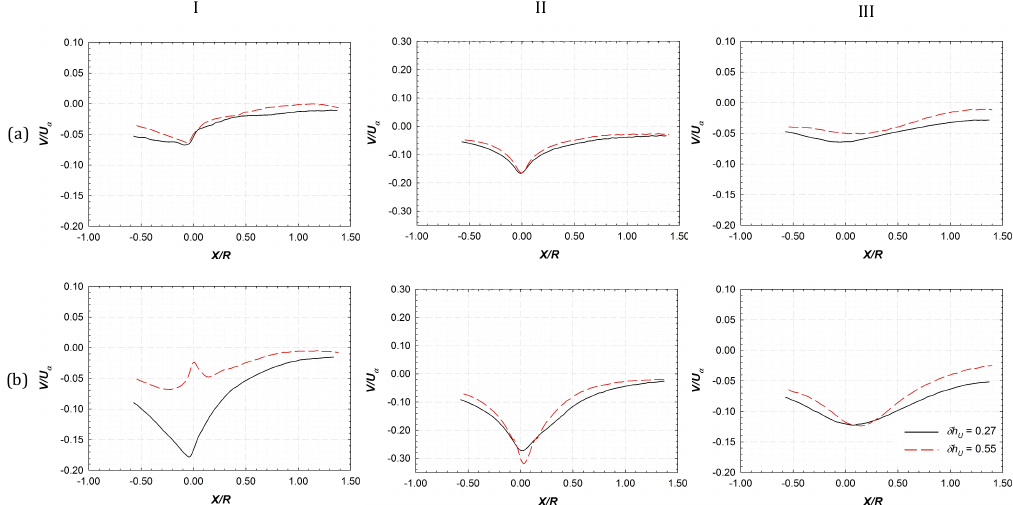
Figure 12. Variation of normalized vertical velocities in the lower bypass region for the rotational velocity of 180 (row a ) and 270 RPM (row b ) and tip clearance ratios of 0.55 and 0.27 on horizontal lines at various depths: Y/ R = − 0.5 (column I ), Y/ R = − 1 (column II ), and Y/ R = − 1.3 (column III ).